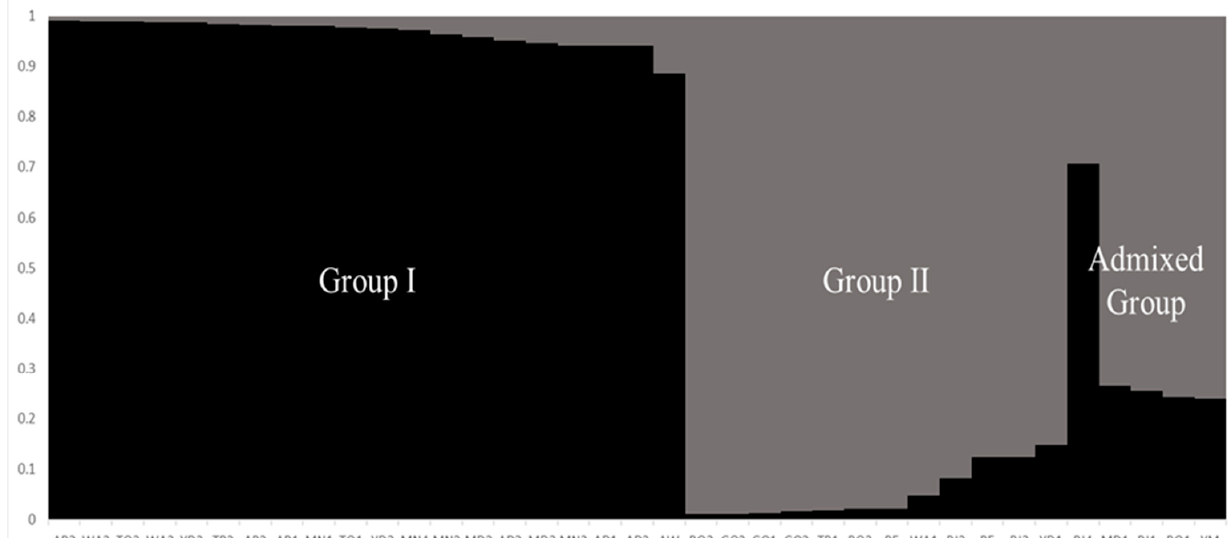
∆ K value, K = 2, of the 37 maize landrace